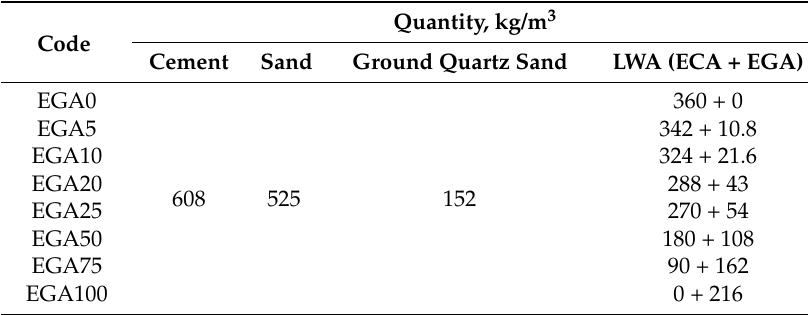
Table 3. Mix proportions of LWAC with mixed LWAs.